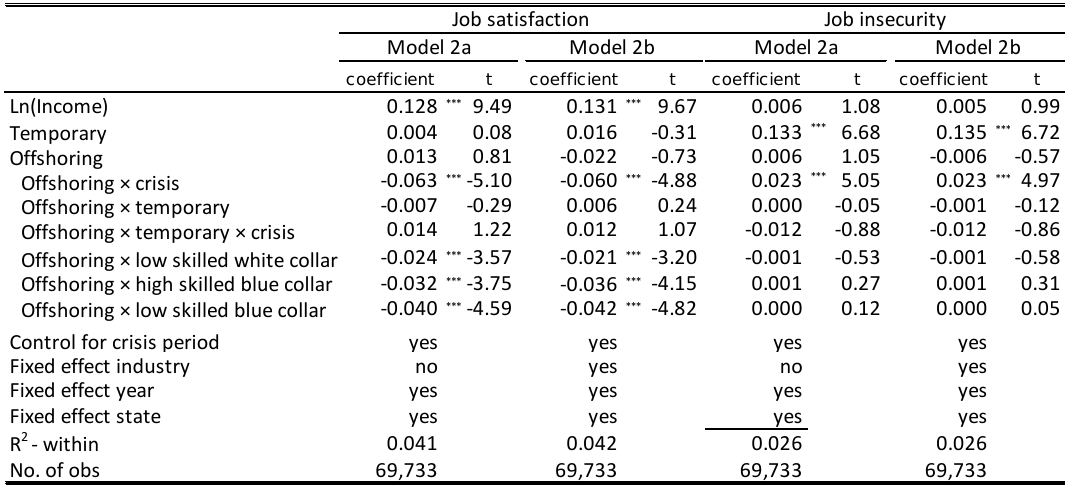
Table 8. Job satisfaction, job insecurity, offshoring and economic